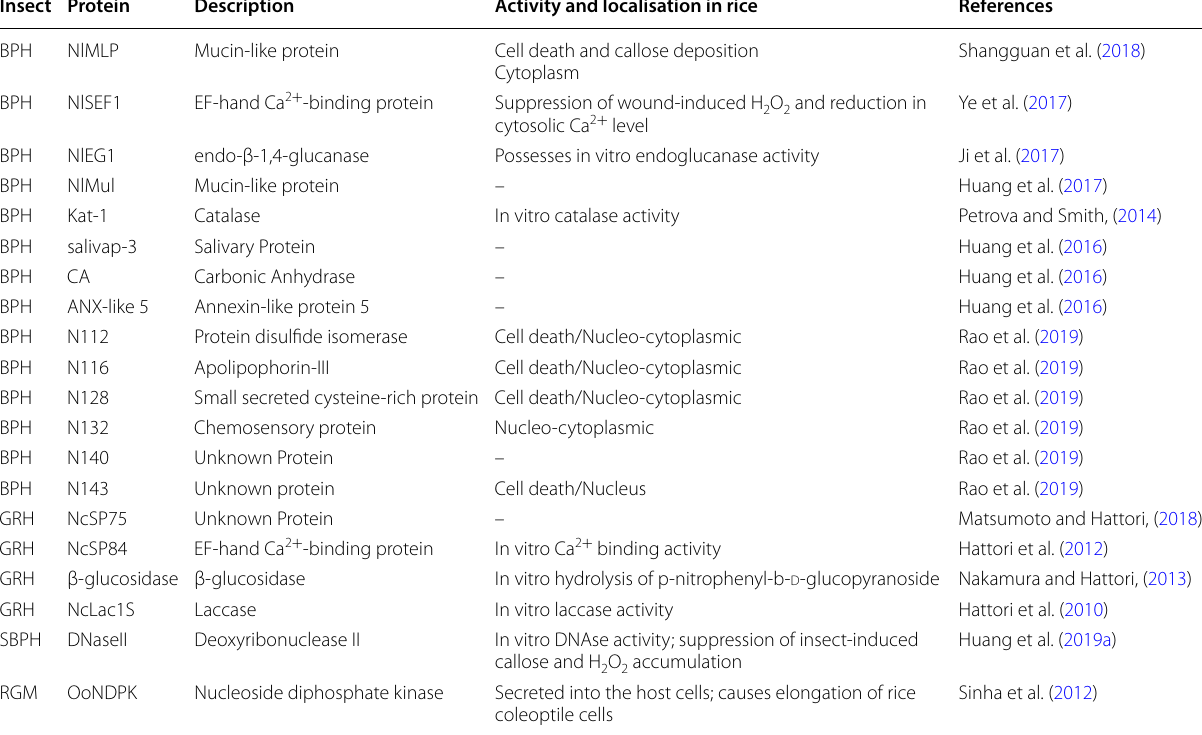
BPH Brown Planthopper, GRH Green Rice Leafhopper, SBPH Small Brown Planthopper, RGM Rice Gall Midge